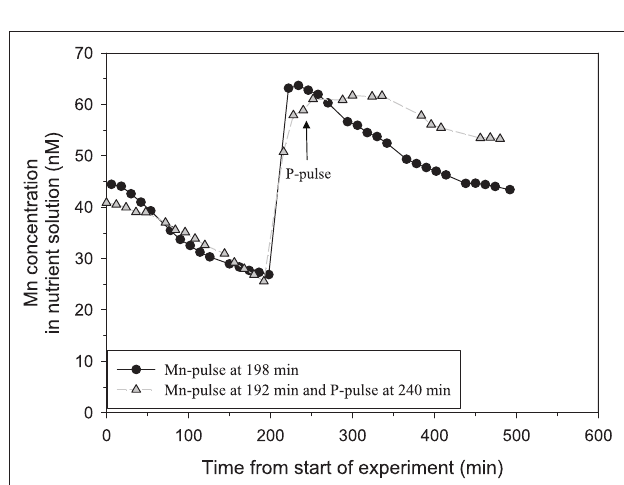
FIgure 3 | Split-root experiment analyzing the root specific effect of addition of a pulse of 500 μM P on Mn net uptake in a 53-day-old plant of